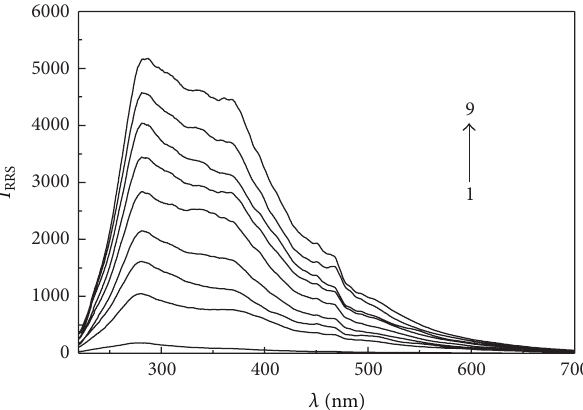
Figure 3: The RRS spectra of ( CdS ) 𝑛 -HAS. and 1: ( CdS ) 𝑛 and 2 ∼ 9: HAS- ( CdS ) 𝑛 (HSA concentration: 0.5, 1.0, 1.5, 2.0, 2.5, 3.0, 3.5, and